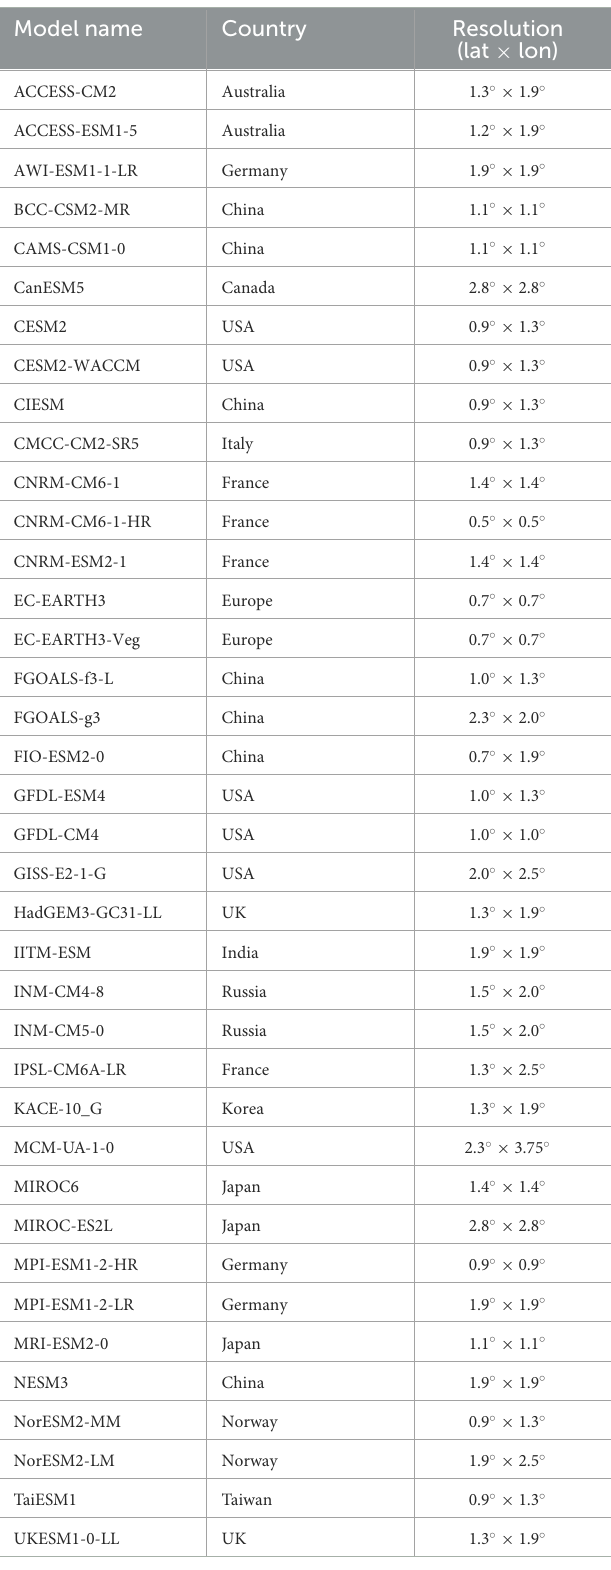
TABLE 2 List of CMIP6 models used in this